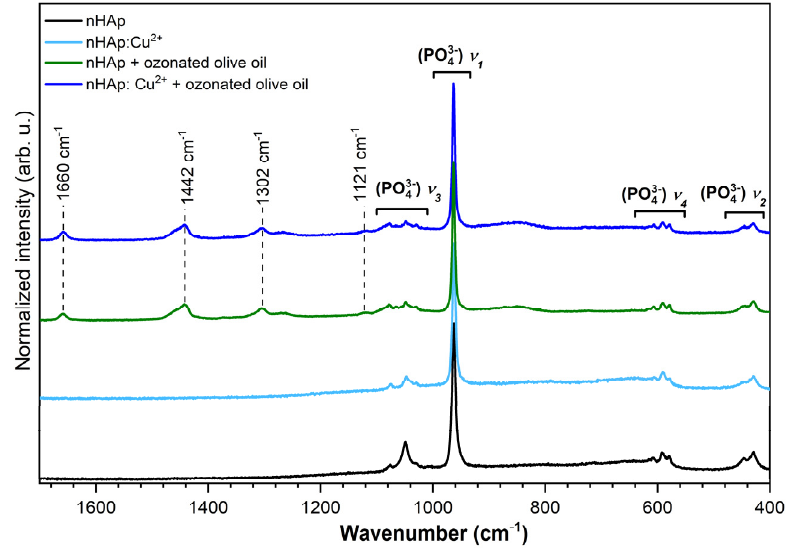
Figure 4. The micro-Raman spectra of nHAp and nHAp doped with 1 mol% Cu 2 + as well as both materials loaded with ozonated olive oil.